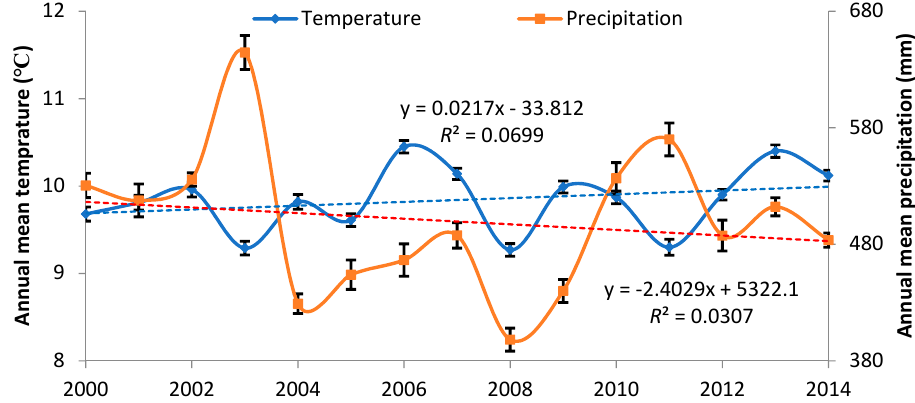
Figure 7. Interannual variations in the annual mean temperature and annual precipitation in the Jinghe River basin from 2000 to 2014.